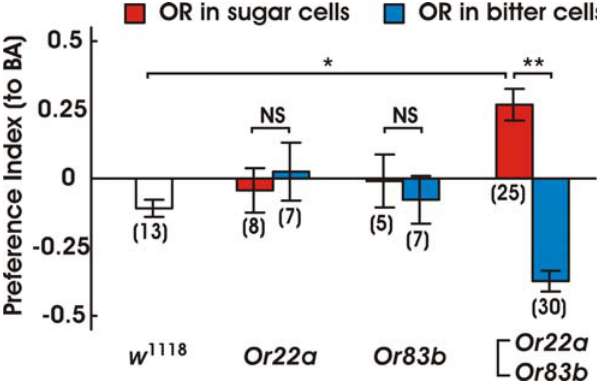
Figure 5. Behavioral choices expressed by flies between a control agar disk and disk treated with butyl acetate. Ordinates: ratio of the density of presence of flies on odorant-treated or non- treated food (mean 6 S.E.M.; number of trails for each is noted in the figure). Abscissa: Wild-type ( w 1118 ) and flies expressing Or22a , Or83b or Or22a + Or83b under the control of Gr5a - or Gr66a -Gal4. Flies expressing both Or22a and Or83b showed an altered preference to butyl acetate as compared to the wild-type ( w 1118 ). Depending on the GRNs that express the Ors , flies exhibited the opposite preferences to the same odorant. BA=Butyl acetate. * P , 0.05, ** P , 0.01 with the